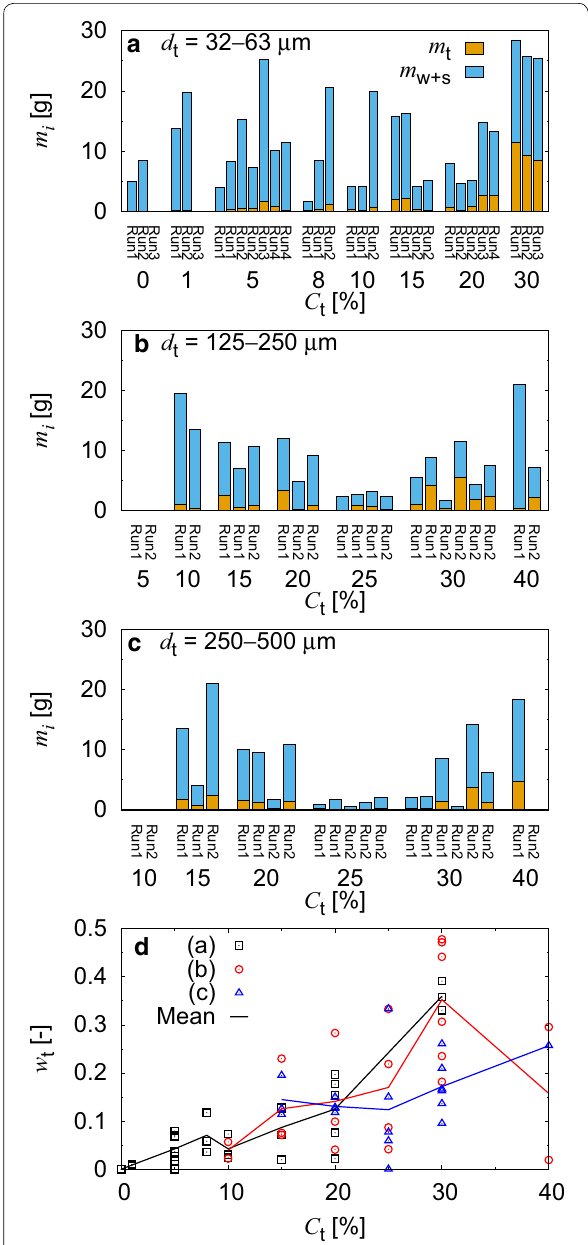
Fig. 11 Composition of aggregates produced in EXP3–5. Effect of tephra concentration, C t , and diameter, d t , on aggregate composition in EXP3–5 ( C s = 10% and t = 5min ): a – c mass composition, m i , and d mass fraction of tephra, w t , in aggregates. a – c Yellow and aqua bars denote the mass of tephra and water plus snow, m t and m w+s , respectively. d Black squares, red circles, and blue triangles are the results in EXP3, EXP4, and EXP5,